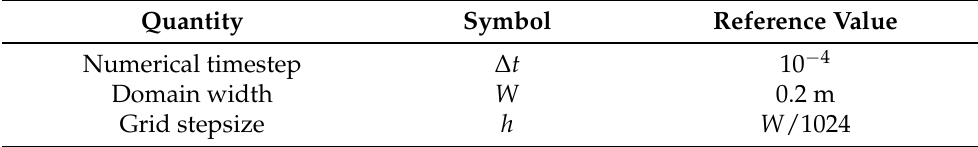
Table 2. Computational